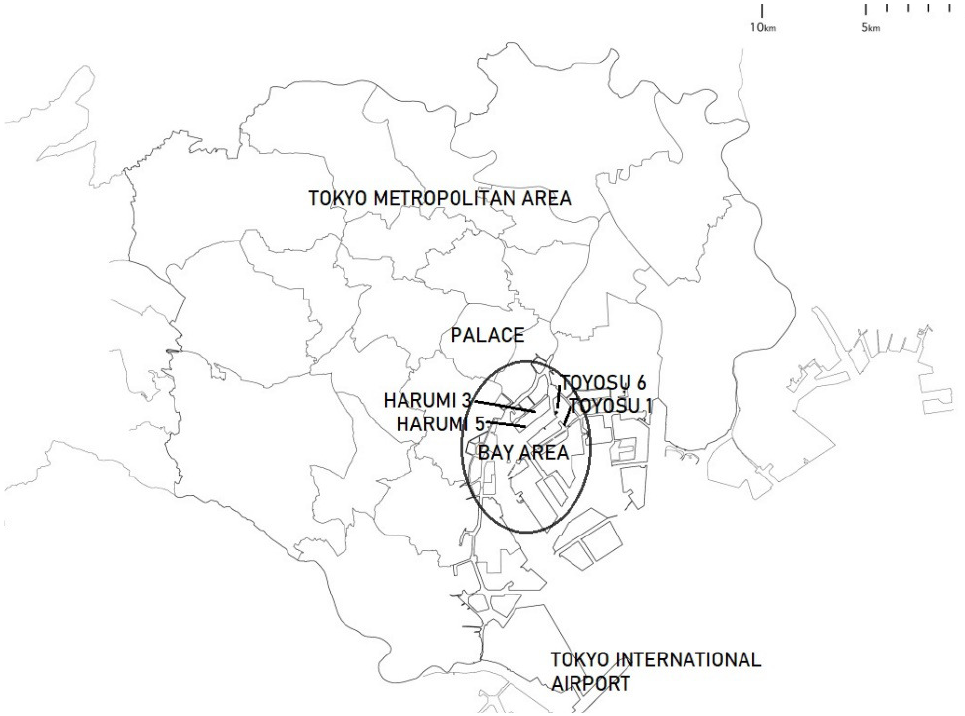
Figure 1. Tokyo Metropolitan Area and bay